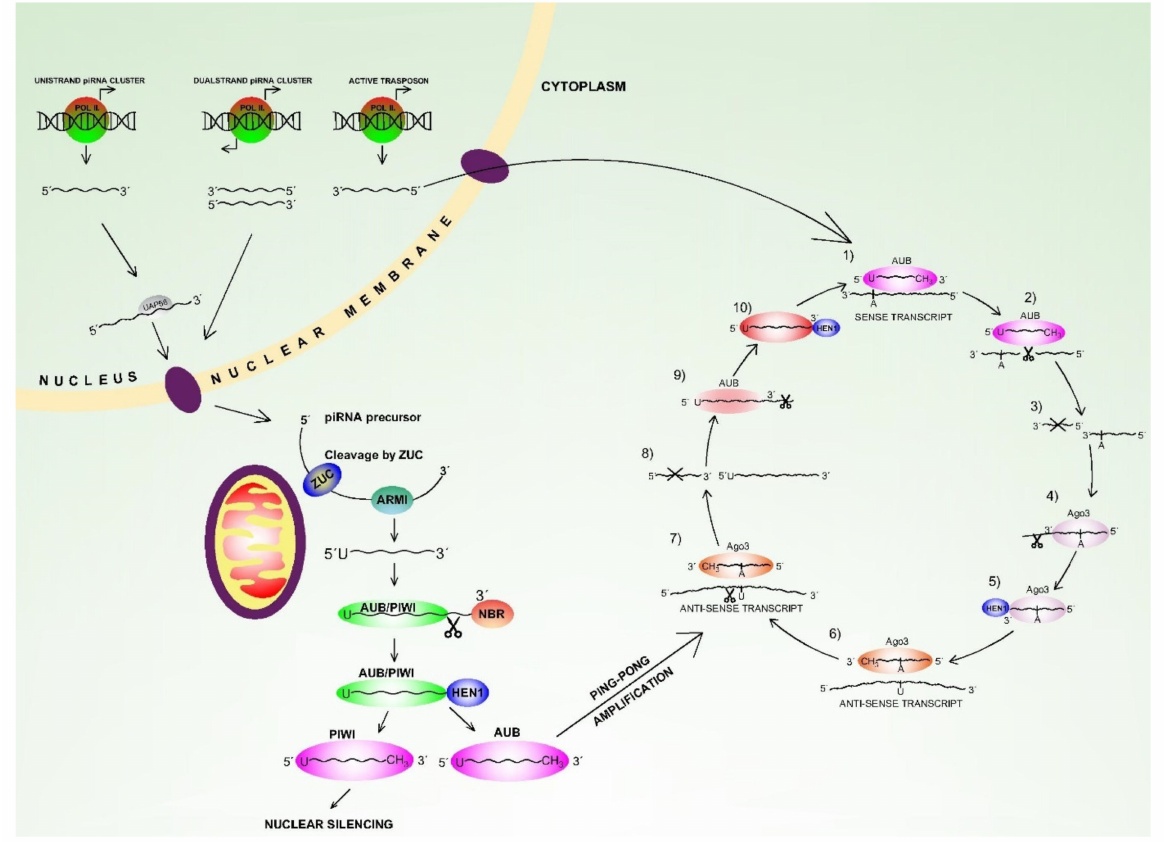
Figure 3. Primary and secondary biogenesis of piRNAs in model Drosophila melanogaster germline cells. The piRNA precursors can be transcribed from uni-strand and dual-strand piRNA clusters by polymerase II. Majority of these precursors are antisense (5 (cid:48) -3 (cid:48) ) relative to transposon transcripts. Export from nucleus to processing sites is mediated by UAP-56 activity. The piRNA precursors are resolved by Armitage (armi) RNA helicase after export, and this leads to their unwinding. The 5 (cid:48) end processing is then mediated by the Zucchini mitochondria-associated nuclease (ZUC). ZUC action transforms the piRNA precursors into pre-piRNAs which are subsequently loaded into Piwi or AUB protein complexes. Here, fragments with Uracil bias at the 5 (cid:48) end are primarily selected. The overhanging 3 (cid:48) end is trimmed with 3 (cid:48) to 5 (cid:48) Nibbler exonuclease (Nib), Hen1 then methylates the 3 (cid:48) end and the piRNAs are then mature. piRNAs loaded into the Piwi protein are then involved in transcriptional gene silencing (TGS) in the nucleus. In contrast, the Aub–piRNA complex triggers the ping-pong amplification pathway by recognising and cleaving transposon mRNA. The product of this cleavage is converted into new sense oriented piRNA (secondary piRNA) which has a 10A bias, and this is subsequently loaded into the Ago3 protein complex and trimmed and methylated. The Ago3-piRNa complex similarly recognises and cleaves the anti-sense cluster transcript, and the product of this cleavage re-initiates the cycle. This provides one-cycle transposon sequence cleavage and simultaneous amplification of the piRNA sequence. The ping-pong amplification is therefore a mechanism of post-transcriptional gene silencing